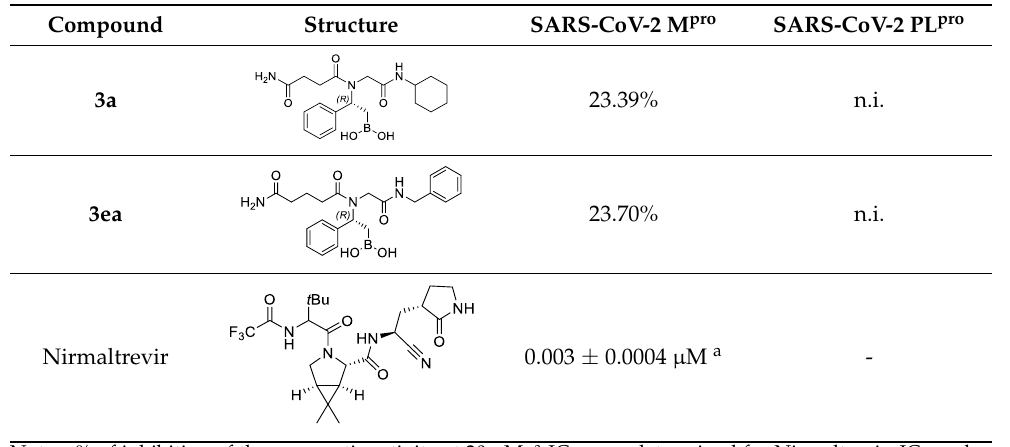
Table 3. Evaluation of the inhibitory activity of 3a and 3ae against SARS-CoV-2 Proteases.